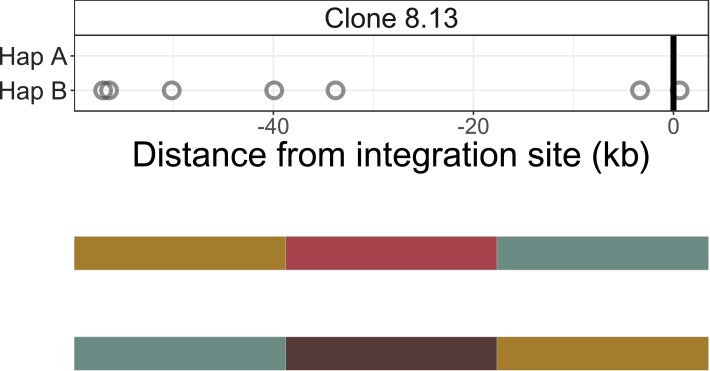
Identification of infected chromosomes - clone 8.13.See legend for Figure 2—figure supplement 1.